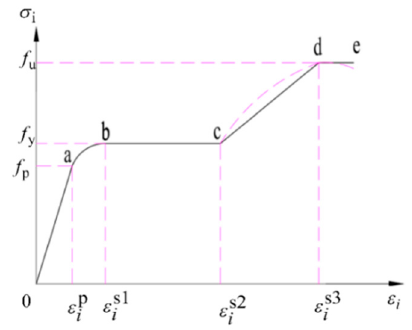
Figure 15. Relationship of steel.